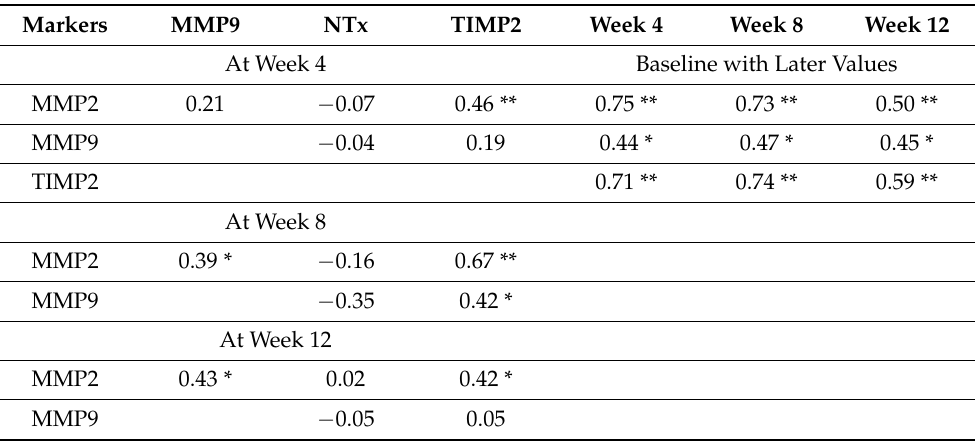
Table 4. Spearman correlation coefficients between % change in different markers.